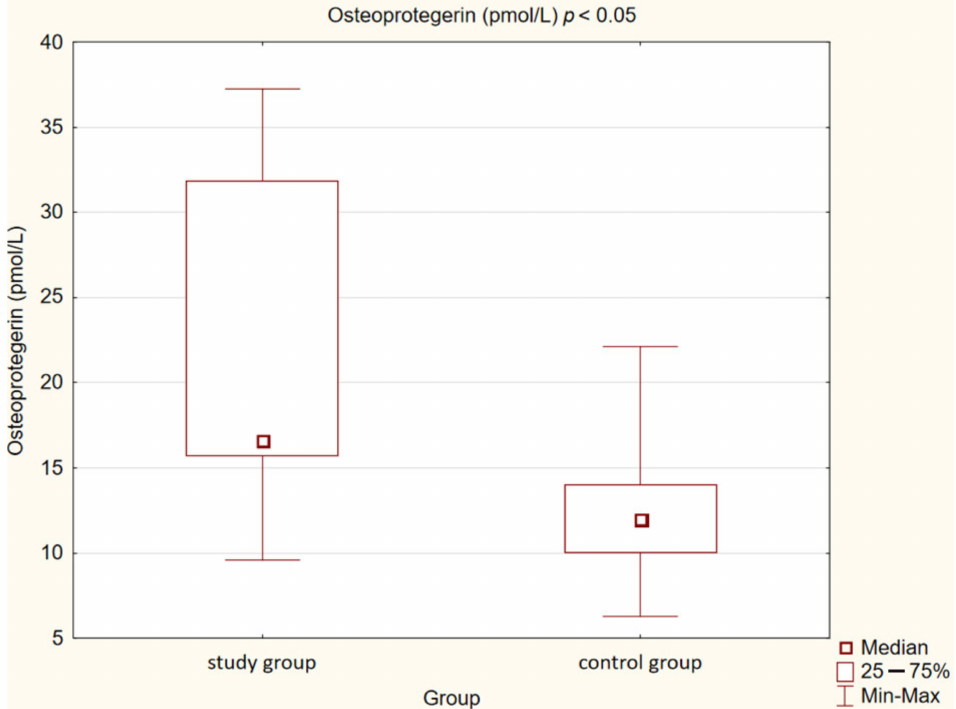
Figure 6. Concentration of osteoprotegerin (OPG) in study and control